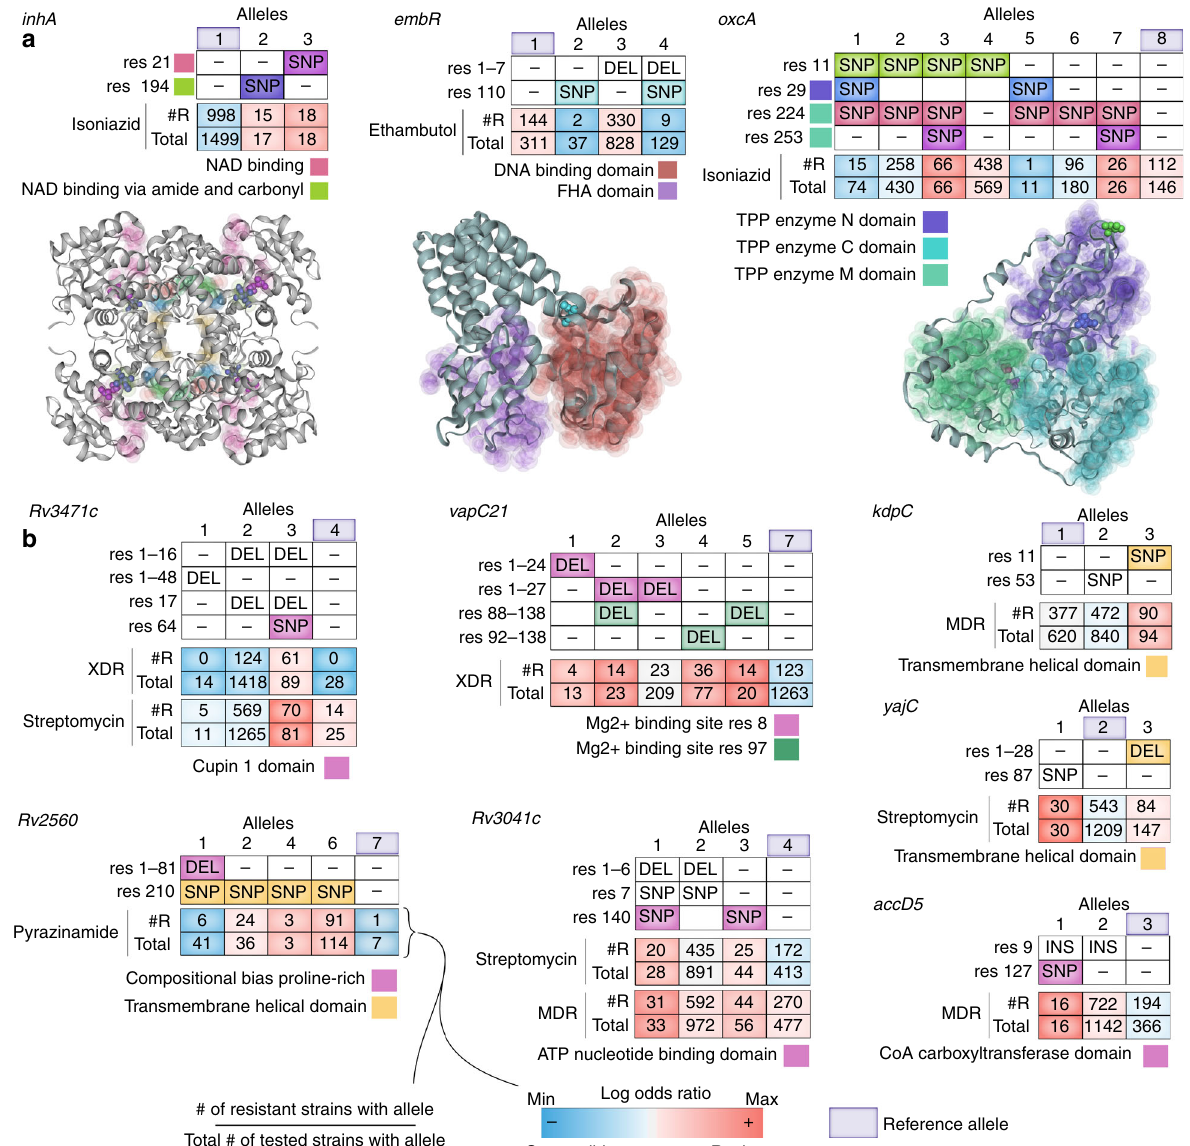
Fig. 3 3D and annotated protein structure mutation maps for identi fi ed AMR genes. a 3D protein structures with mapped mutations are shown for inhA , embR , and oxcA . The colors adjacent to and within the structural mutation table correspond to domains and mutations displayed on the protein structure, respectively. b Mutation tables for seven new AMR genes. The colors in the mutation table correspond to the incidence of an annotated structural feature located below the table. The two rows directly below the mutation table are colored according to the log odds ratio between the allele frequency and AMR phenotype. Two AMR classes are shown for Rv3471c and